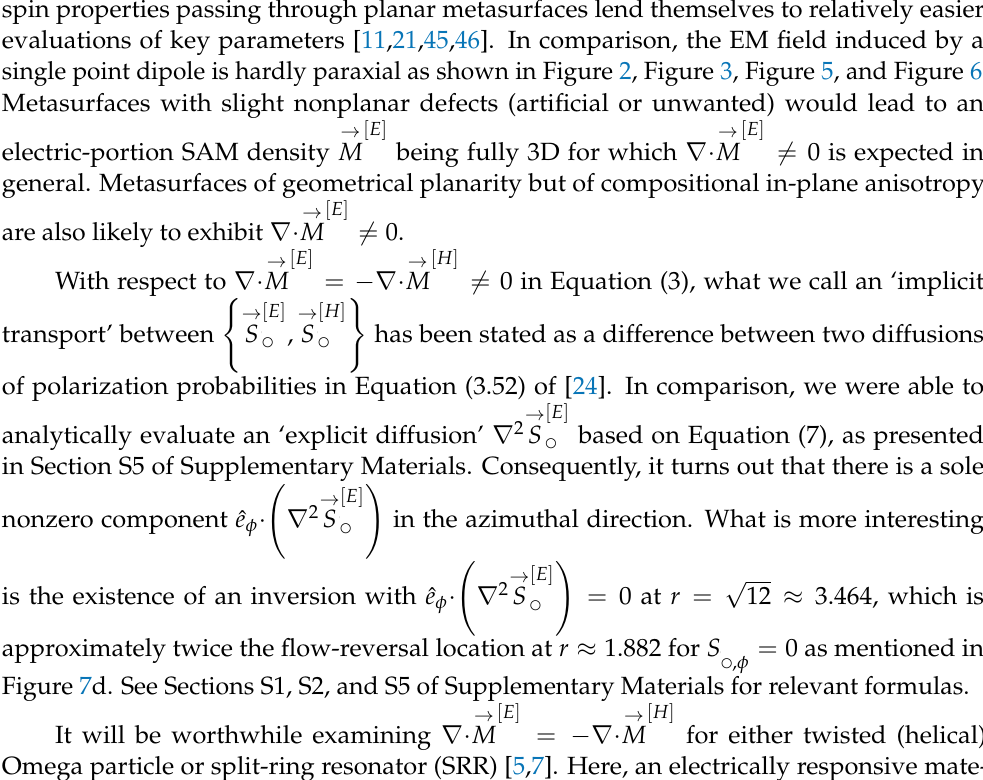
  Figure 1. ( a ) Decomposition of a Poynting vector P into an orbital energy flux O and a spin   energy flux S . Besides, M is a spin angular momentum (SAM) density. ( b ) The coordinate systems. On the origin lies a primary electric point dipole represented by its unit vector ˆ p . ( c ) A linear dipole ˆ p with its dipole axis lying parallel to the vertical axis leads to a pencil-hull-like  tapered cylindrical surface designating higher values for the degree of circular polarization (DoCP). with its dipole axis lying on the horizontal plane leads to a filled solid ( d ) A circular dipole ˆ p  ○ cone of higher values of DoCP. 